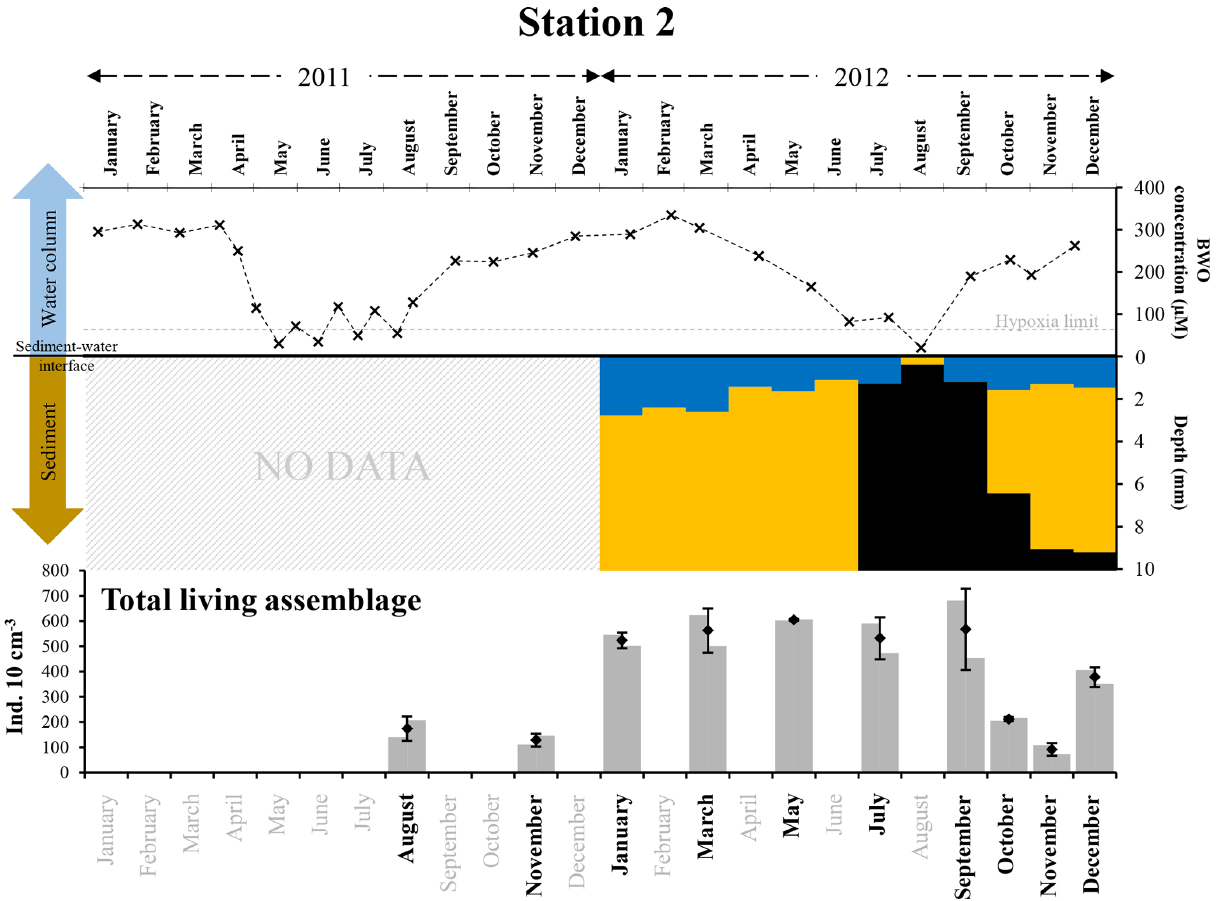
Figure 9. The top panel represents bottom-water oxygen concentrations (µmolL − 1 ) in 2011 and 2012 at station 2, from Donders et al. (2012) and Seitaj et al. (2017). The grey horizontal dotted line indicates the hypoxia limit (63µmolL − 1 ). The middle panel represents the depth (mm) distribution of the oxic (blue), suboxic (orange, absence of oxygen and sulfides) and sulfidic (black) zones within the sediment in 2012. The bottom panel shows the total living foraminiferal abundances for both replicates (grey bars), mean abundances (diamonds) and standard deviations (black error bars) calculated for the two replicates, for all investigated months (in bold) in 2011 and